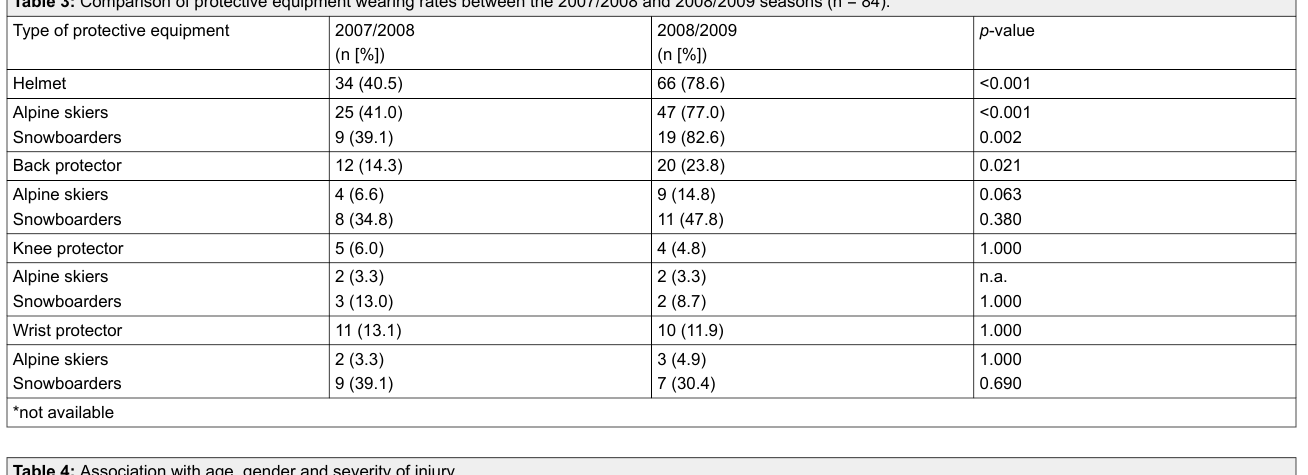
Table 4: Association with age, gender and severity of injury. Change 2007/2008 to 2008/2009 Age (mean group 0 and 1 / p